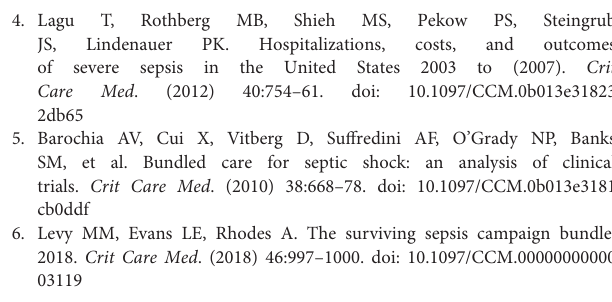
Supplementary Table 4 | The baseline characteristics of external validation cohort. Supplementary Table 5 | The baseline laboratory data and vital statistics of external validation cohort. Supplementary Table 6 | A subset analysis for septic shock cohort with external